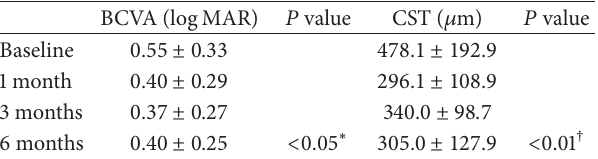
Table 2: Mean best corrected visual acuity and central subfield thickness at different points.